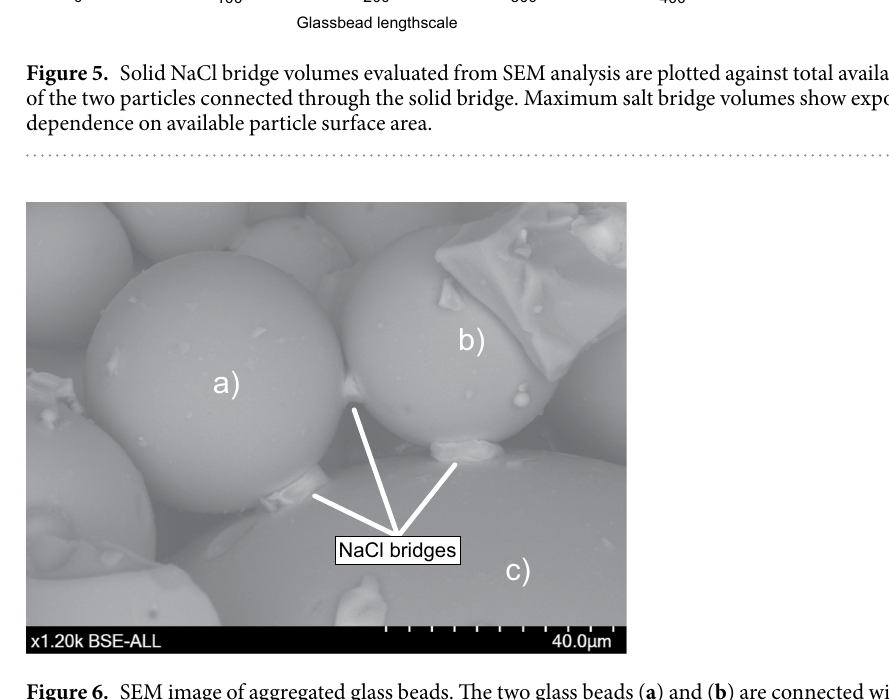
Figure 6. SEM image of aggregated glass beads. The two glass beads ( a ) and ( b ) are connected with each other through a smaller solid NaCl bridge than they are to glass bead ( c ). Glass bead ( c ) is larger in volume and therefore surface and allows for the establishment of more voluminous